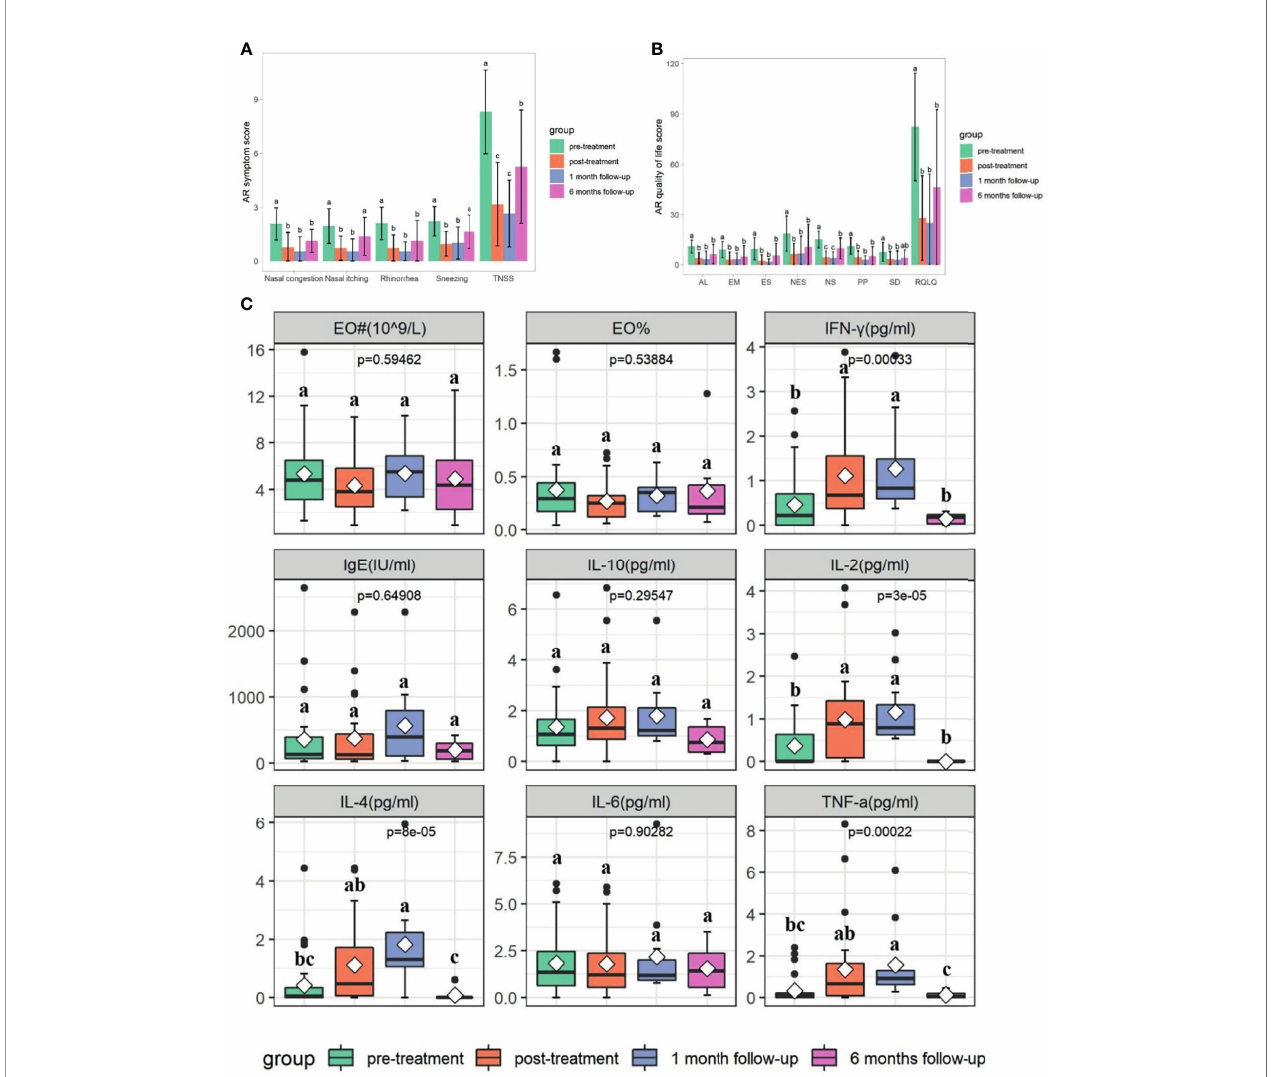
FIGURE 1 | Changes in TNSS, RQLQ, EO%, EO counts, and cytokines at different time points based on Kruskal-Wallis test (p<0.05). (A) Changes in TNSS at different time points. (B) Changes in RQLQ at different time points. AL, Activity limitation; EM, Emotions; ES, Eye symptoms; NES, Non-eye/nasal symptoms; NS, Nasal symptom; PP, Practical problem; SD, Sleep disorders. (C) Changes in EO%, EO counts, and cytokines at different time points. EO# is the abbreviation of EO counts. Cytokines including IL-2, TNF-a, IFN-g, IL-4, IL-6, and IL-10. Letters (a, b, and c) indicate the difference grouping among different time points. Groups that do not share a common letter are signi fi cantly